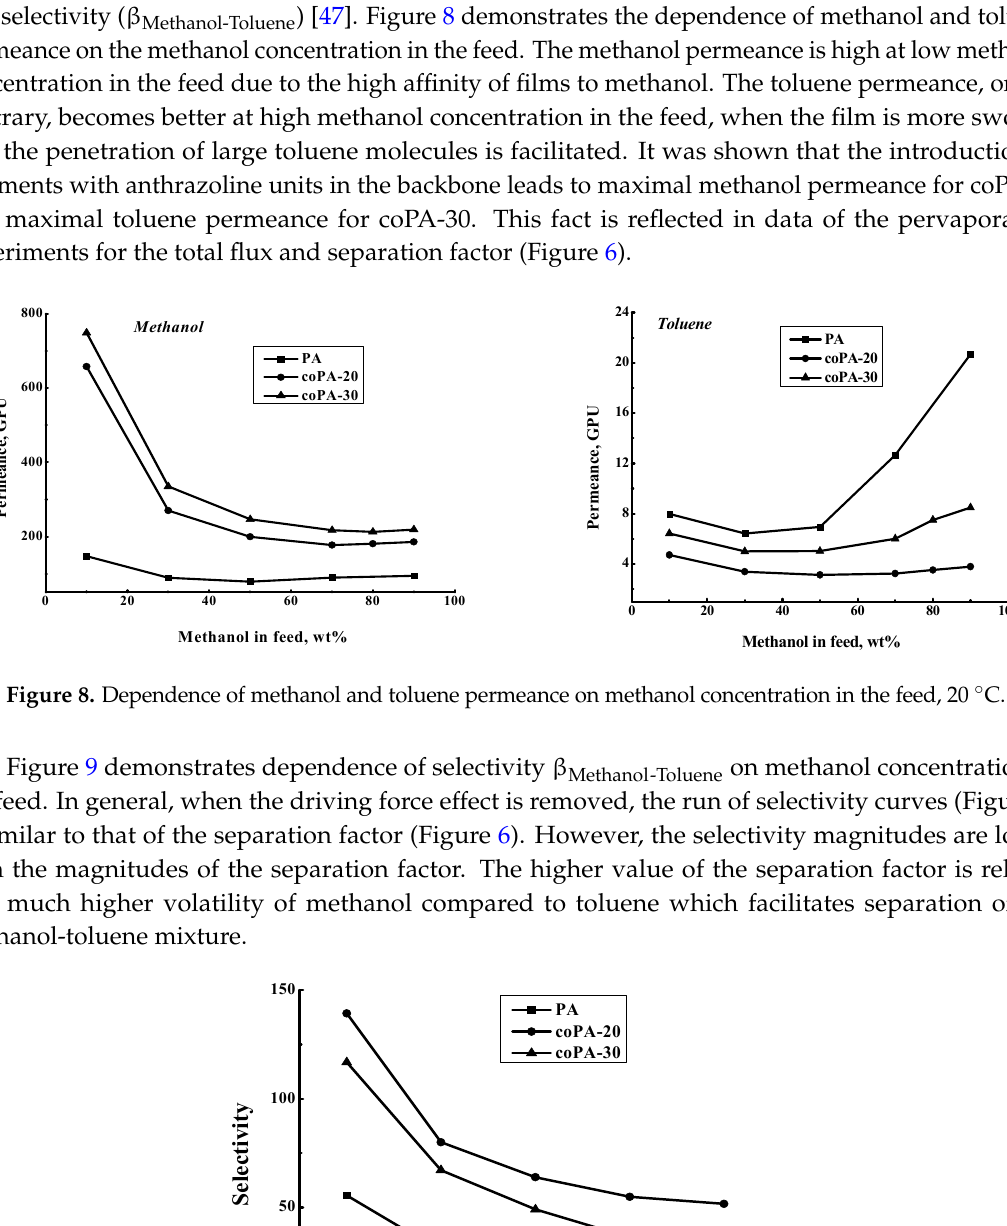
Figure 7. Dependence of total flux and separation factor α Methanol/Toluene on temperature for the pervaporation of azeotropic methanol–toluene (70:30 wt %) mixture through coPA films, 20 ° С .